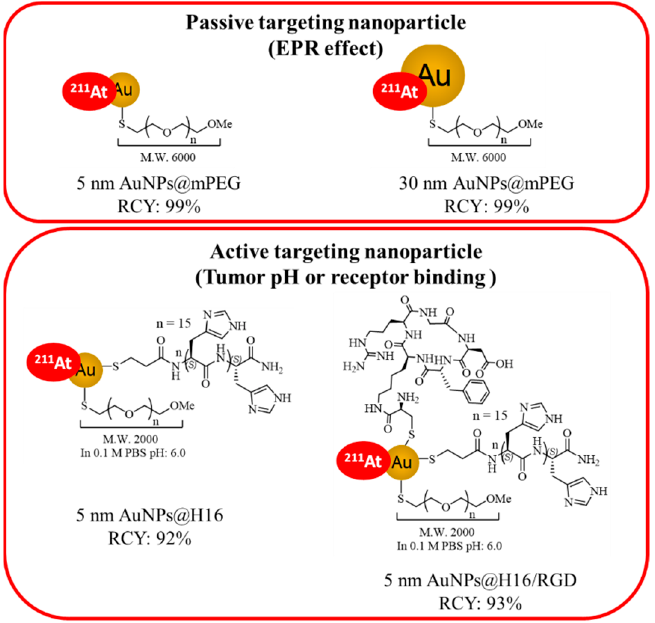
Figure 1. Four kinds of 211 At-labeled functional AuNPs designed for the study: 5 nm and 30 nm 211 At-AuNPs@mPEG; 5 nm 211 At-AuNPs@H16 and 211 At-AuNPs@H16/RGD. RCY: radiochemical yield.